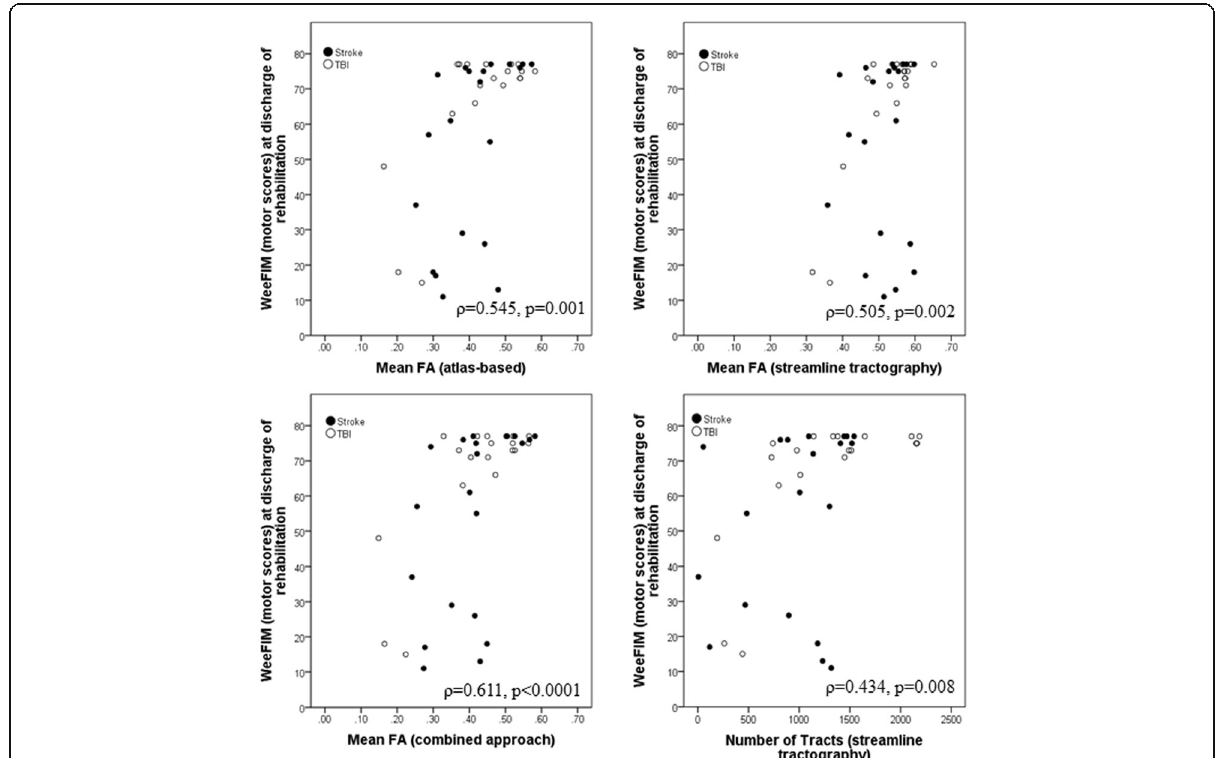
Fig. 5 Scatterplots showing the relationship between the mean fractional anisotropy (FA) or the number of tracts and motor scores of the functional independence measure for children at discharge of rehabilitation for the different software methods for the corticospinal tracts. Nonparametric partial correlation analysis included age, rehabilitation time, and timing of magnetic resonance imaging after injury as covariates. TBI , traumatic brain injury; WeeFIM , functional independence measure for